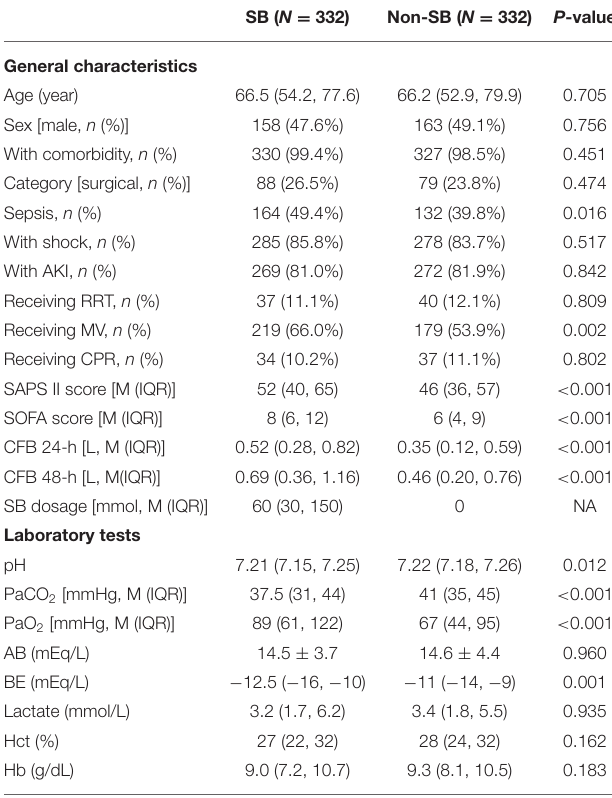
TABLE 1 | Characteristics of patients in the SB group and non-SB group after